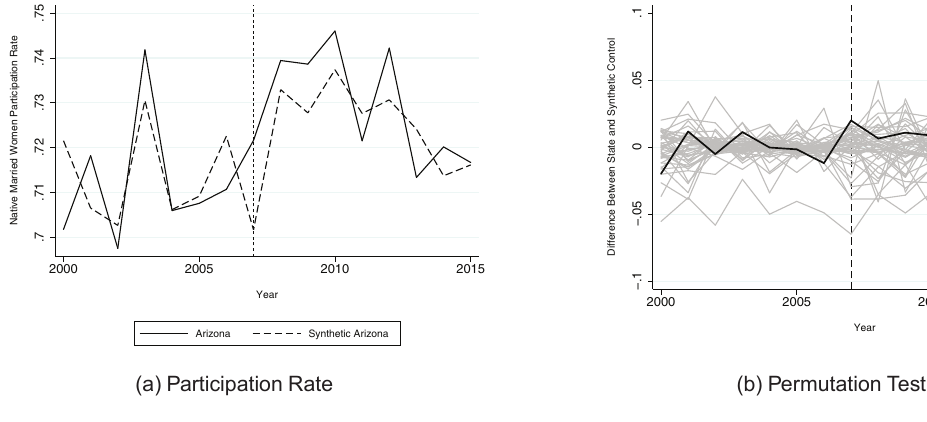
Native married women participation rate